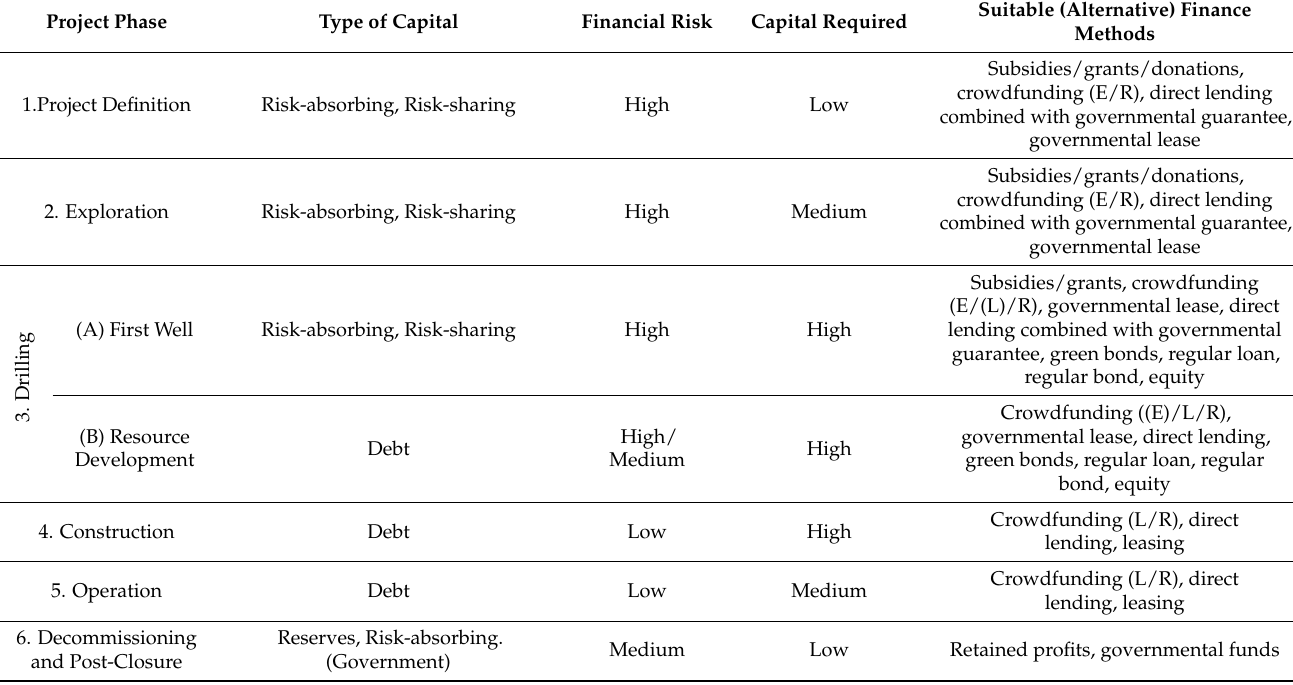
Table 2. Relationship between geothermal project phase and the capital